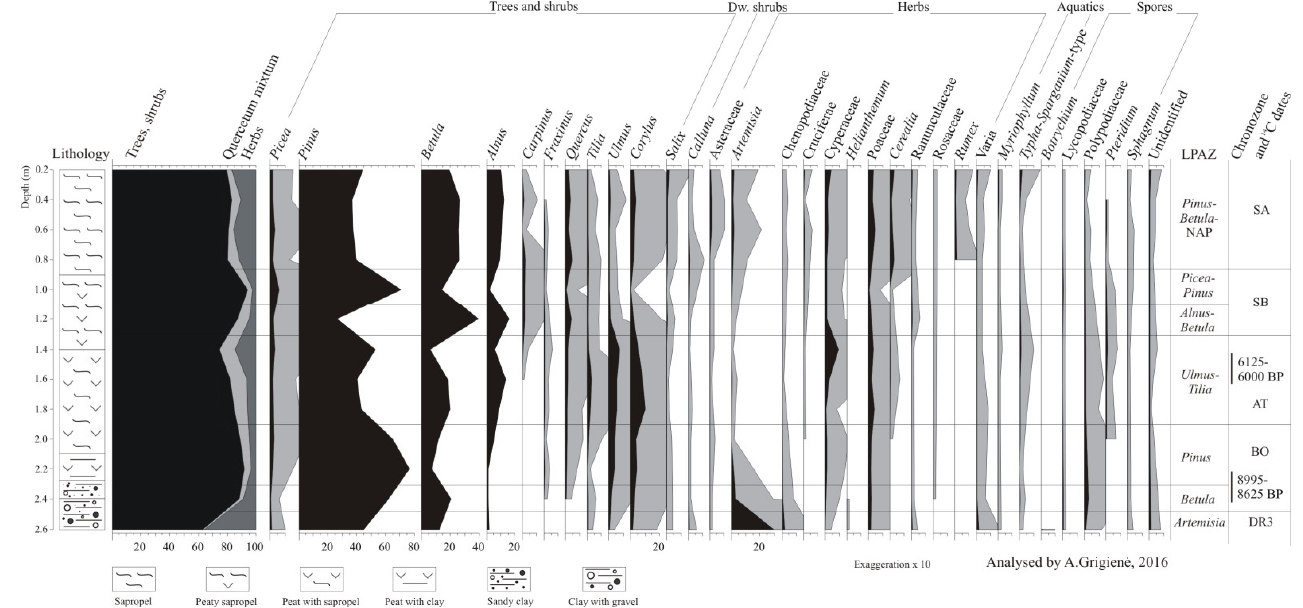
Figure 7. Percentage pollen diagram of the core from Lake Salot ė .